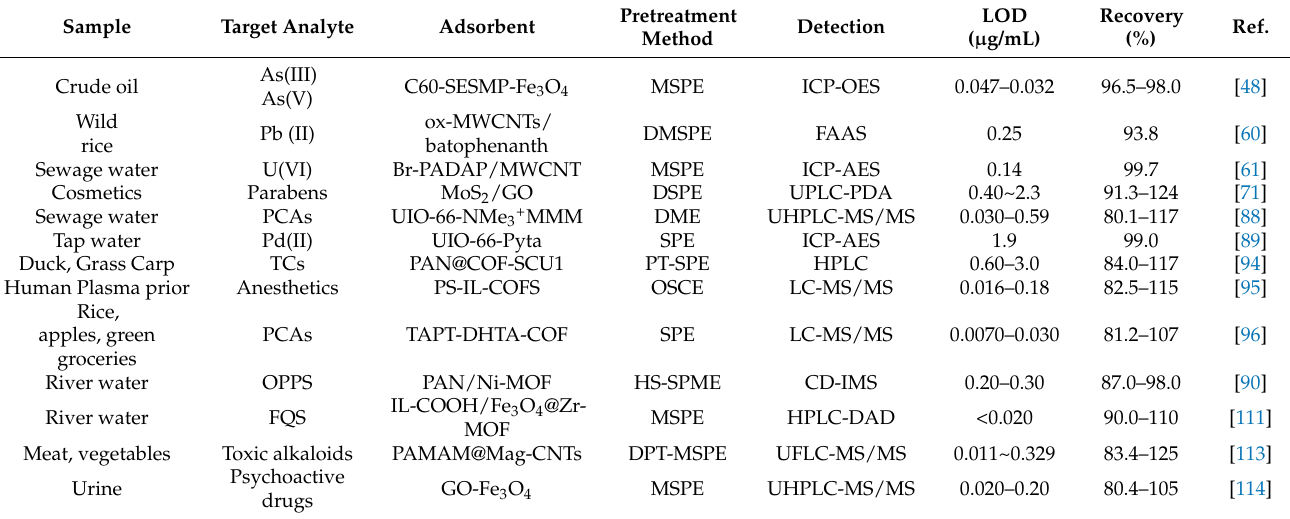
Table 1. The summary of the properties of nanomaterials as adsorbents in combination with other